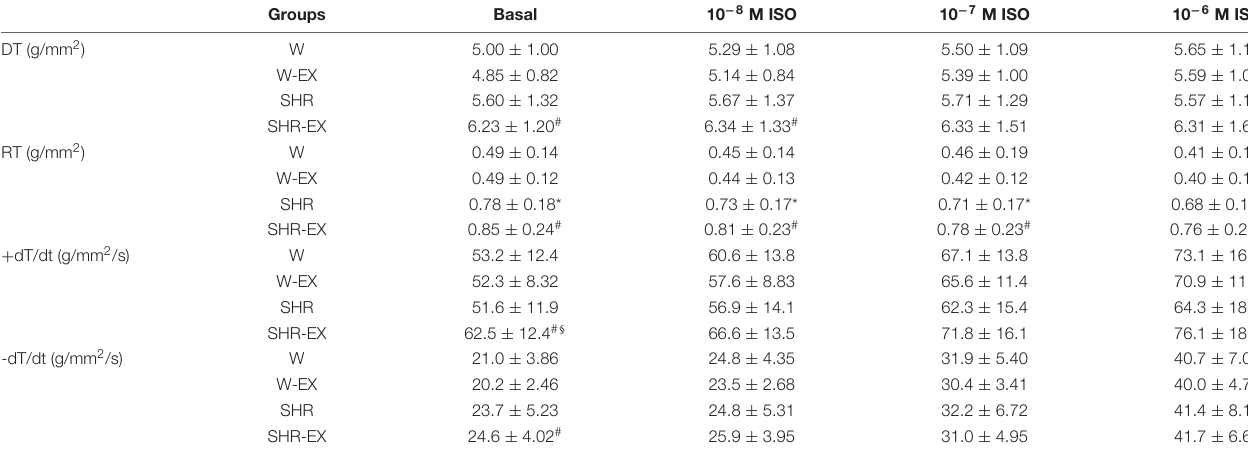
TABLE 6 | Papillary muscle function after isoproterenol (ISO) stimulation.